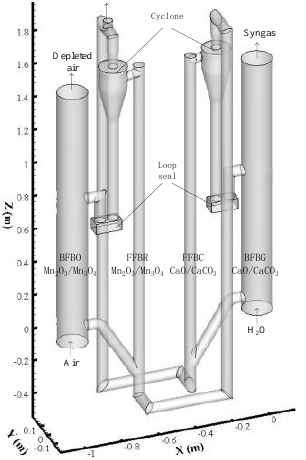
Figure 1. Sketch of the quadruple fluidized bed